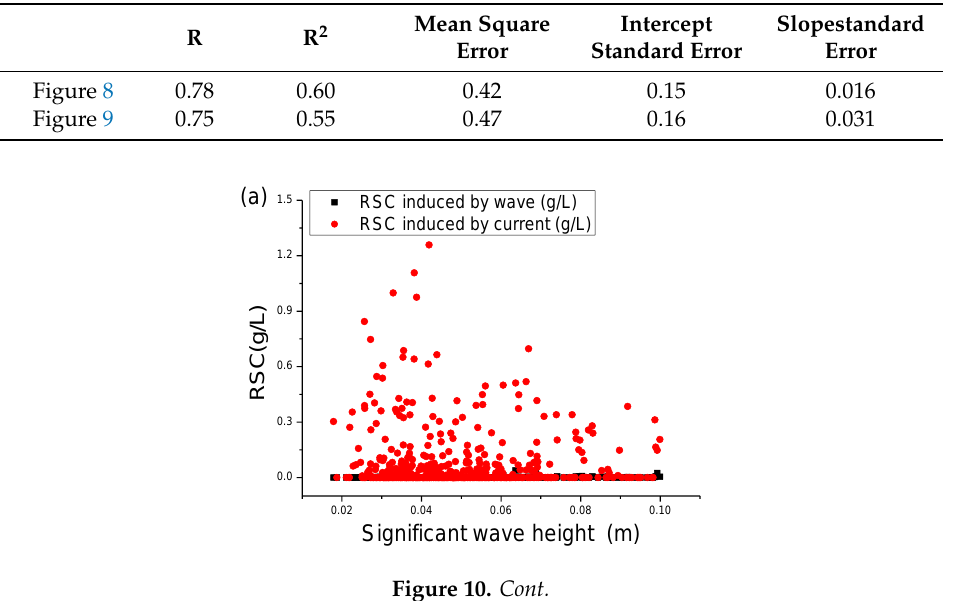
Figure 9. Suspended sediment concentration (SSC) as a function of the shear stress calculated by Equation (3) from 13–17 December 2014 (linear fit of the total stress Pearson’s r is 0.75). Table 3. The correlation and error of Figures 8 and 9.